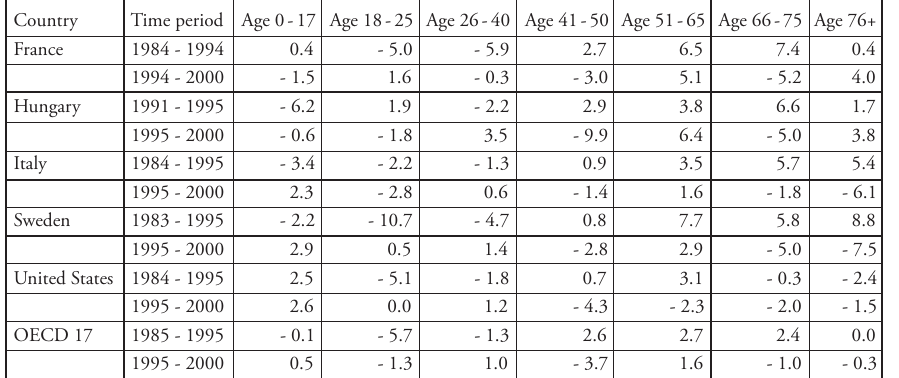
Table 3: Changes in relative incomes by age groups, ca. 1984-2000